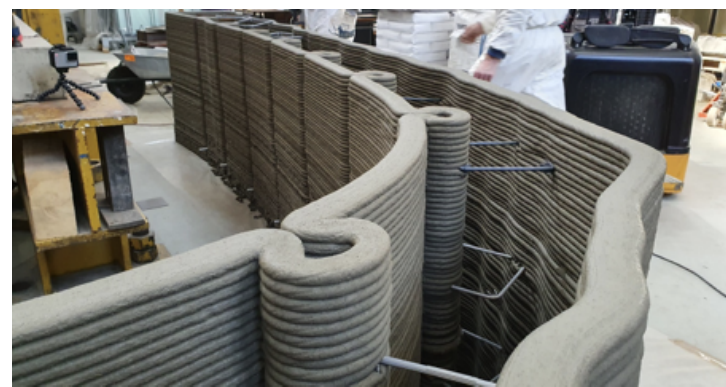
Figure 7. Construction of the wall during the printing.